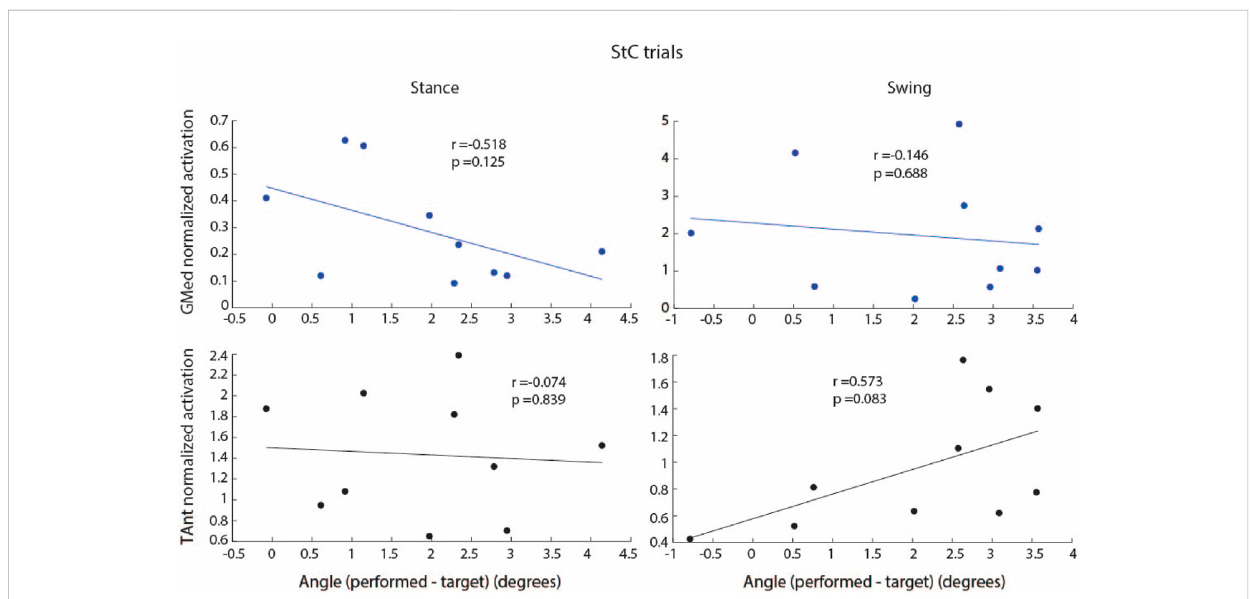
FIGURE 7 Correlation between integrated EMG activity of GMed (blue dots and regression lines) and TAnt (black dots and regression lines) and the error (mathematicalsubtraction)betweenmaximumperformedankleangleandmaximumtarget angleforstanceandswing phasesduring StCtrials.Eachdot represents each subject.